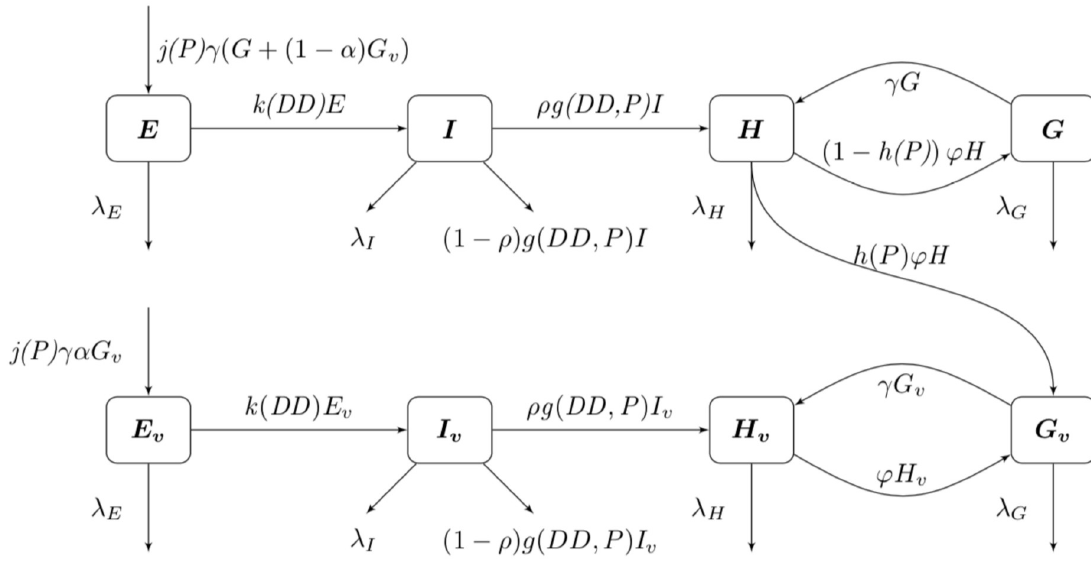
Fig 2. Flow diagram of La Crosse virus transmission